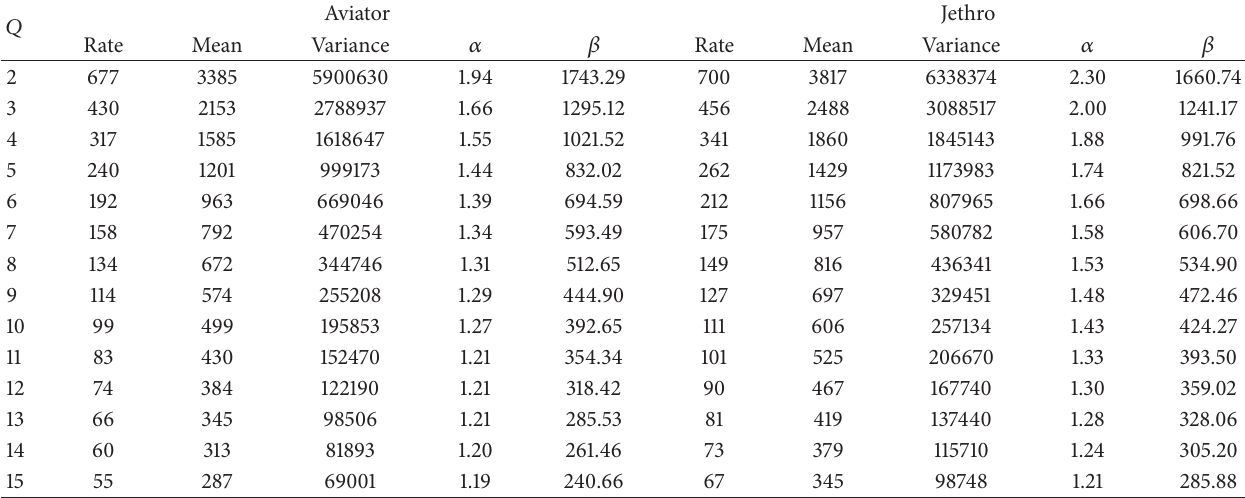
Table 1: Statistics for Aviator (22 min) and Jethro Tull (30,55 min) in unconstrained mode, constant quantizer 𝑄